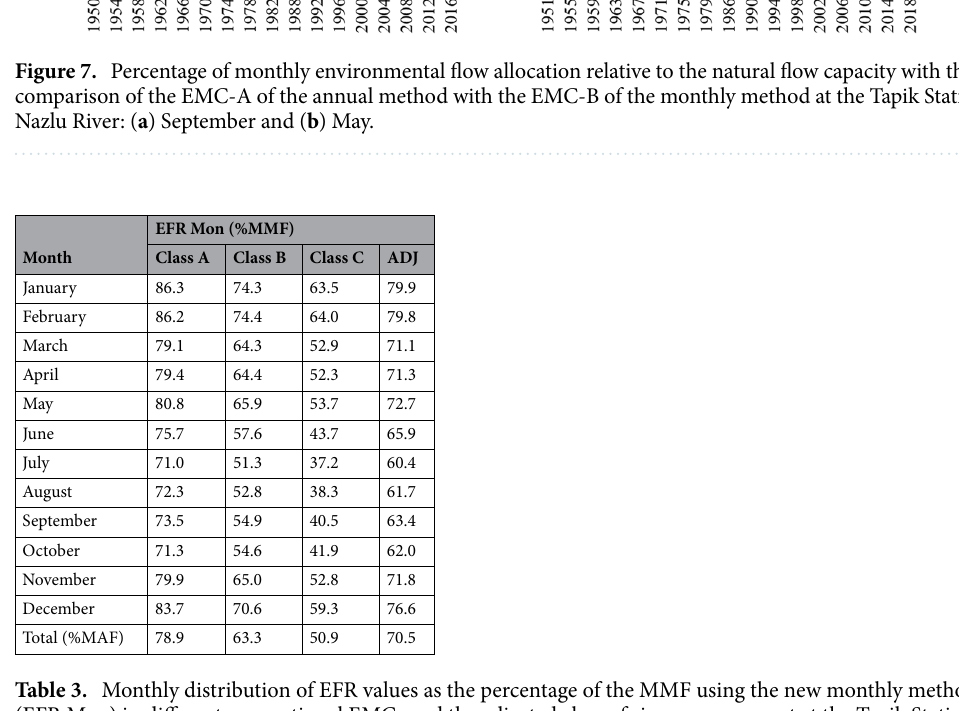
Table 3. Monthly distribution of EFR values as the percentage of the MMF using the new monthly method (EFR Mon) in different conventional EMCs and the adjusted class of river management at the Tapik Station, Nazlu